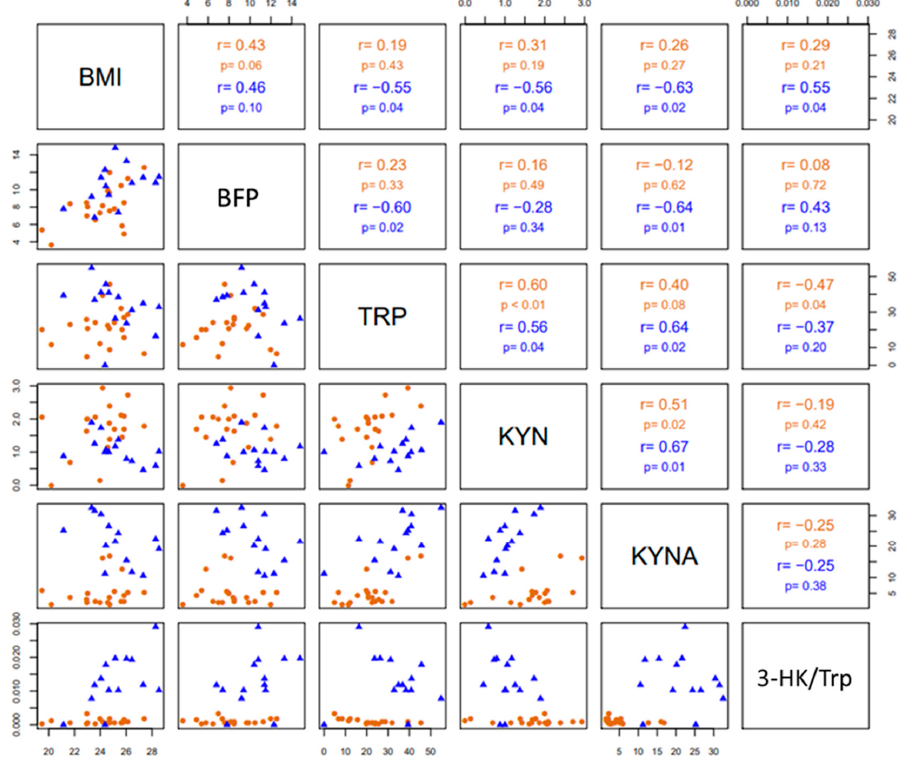
Figure 5. The lower triangular matrix contains the scatterplot for each pair of variables for divers and SHRSs. The upper triangular matrix includes the Spearman’s rank correlation coefficient (r) with its respective associated p -value ( p ) calculated for each group.